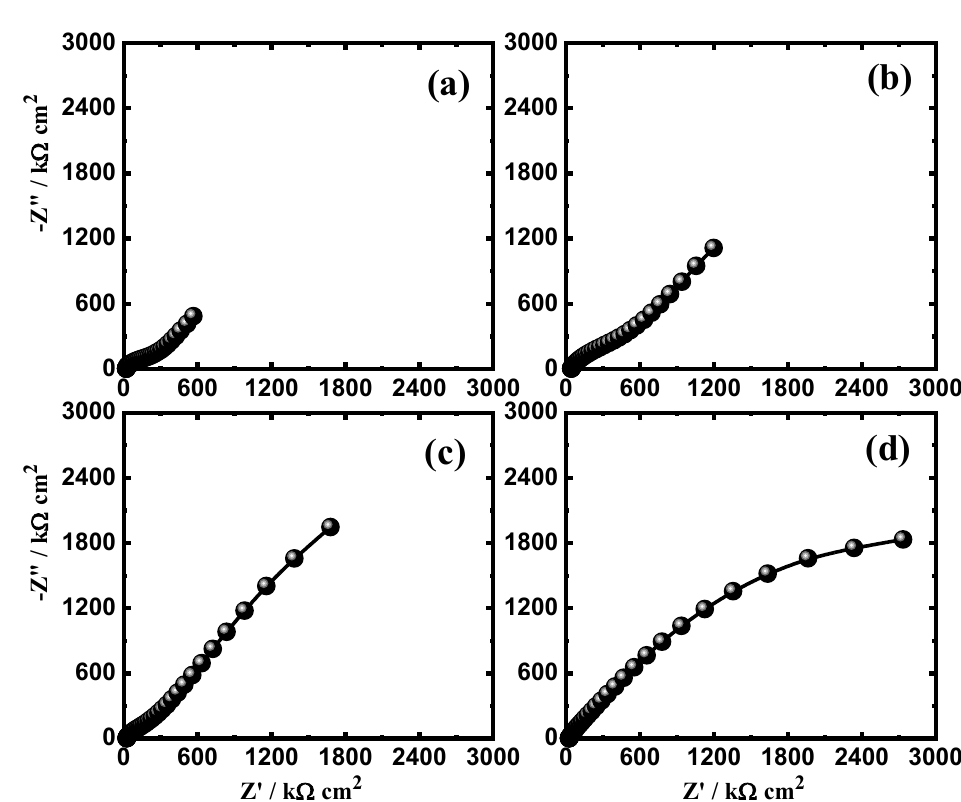
Figure 10. Nyquist plots obtained for iron samples after 1 h immersion in ( a ) 3.5% NaCl solutions in the absence and presence of ( b ) 5 × 10 −5 M HAO, ( c ) 1 × 10 −4 M HAO, and ( d ) 5 × 10 −4 M HAO.